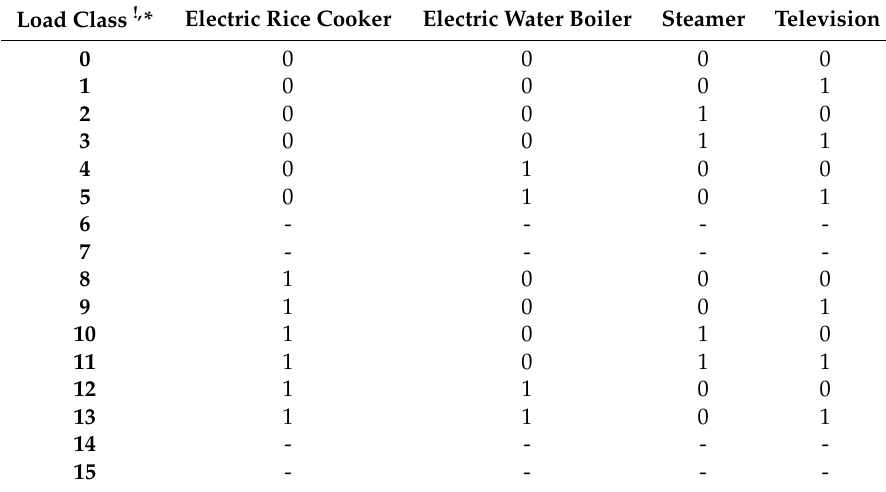
Table 2. Twelve classes addressed in this